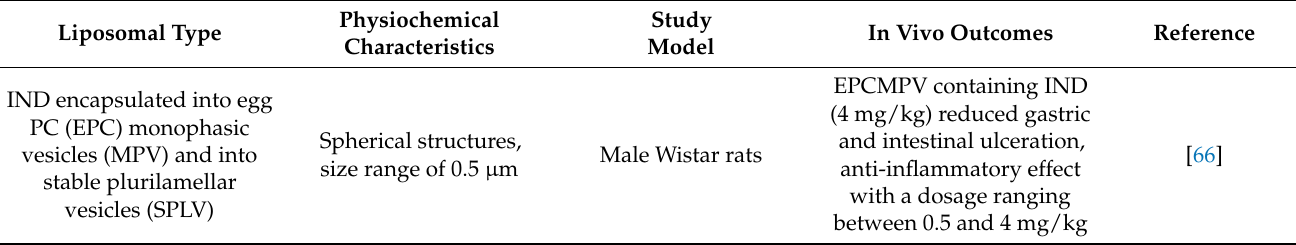
Table 2. Liposomes formulations of